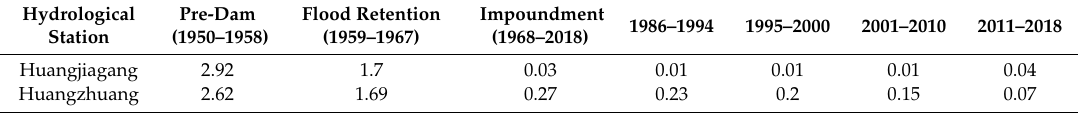
Table 4. Average annual sediment concentration (kg / m 3) at hydrological stations.